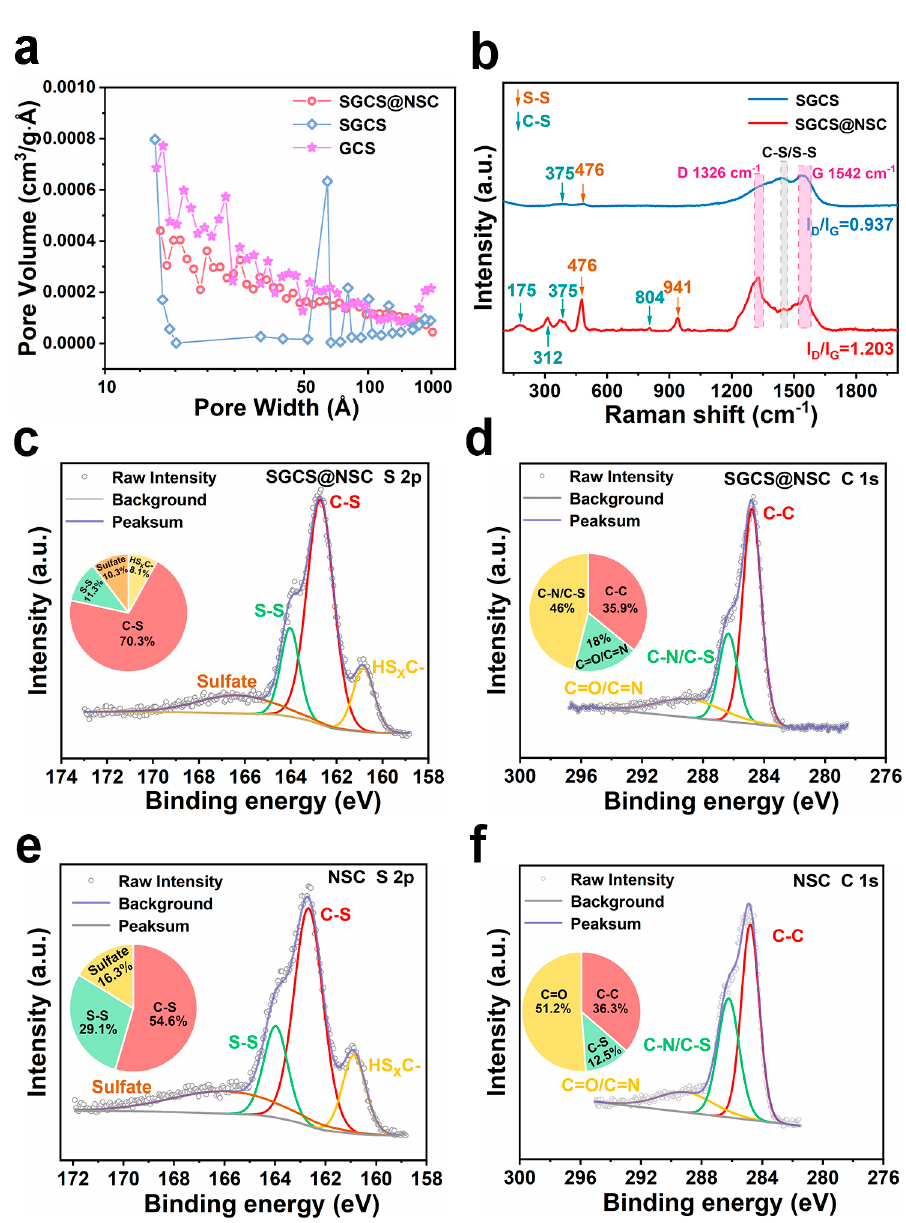
Figure 2. ( a ) Pore distribution curves of SGCS@NSC, SGCS, and GCS. ( b ) Raman scattering spectra of SGCS@NSC and SGCS. ( c – f ) The high-resolution XPS of S 2p and C 1s of SGCS@NSC and SGCS. The Raman spectra of SGCS@NSC and NSC show peaks at 175, 312, 375, and 804 cm − 1 in the 100–1000 cm − 1 wavenumber region, indicating the stretching, bending, and defor- mation of the C-S bond (Figures 2b and S2b) [33,34]. The stretching of the S-S bond con- tributes to the two peaks at 476 and 941 cm − 1 [35]. In addition, the two peaks near 1480 cm − 1 also correspond to the stretching of C-S/S-S bonds [33,36]. The characteristic peaks of